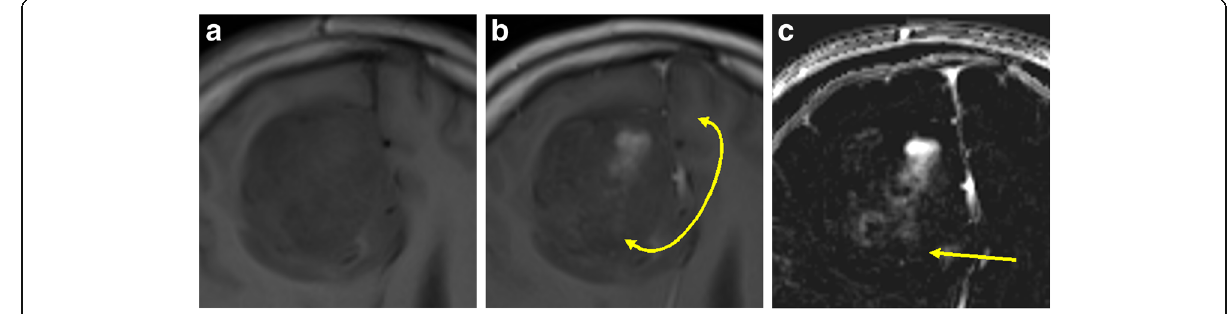
Fig. 4 The quantitative enhancement (QE) analysis system analyses both unenhanced ( a ) and contrast-enhanced ( b ) T1-weighted images allowing accurate quantification of enhancement in regions that are much darker than normal appearing white matter (arrow on the QE map in c